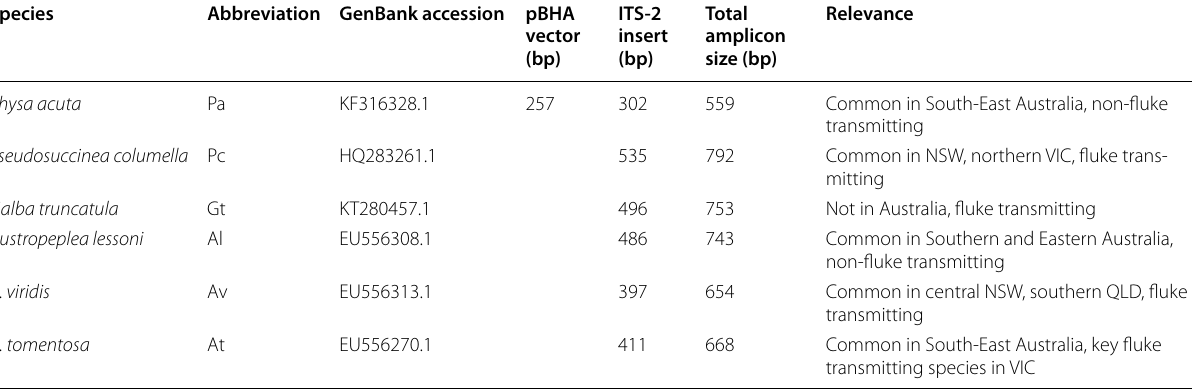
Table 5 Common snails found in Australia used for DNA extraction for specificity panel. Synthetic constructs containing partial ITS-2 insert of snails and corresponding amplicon size used in this